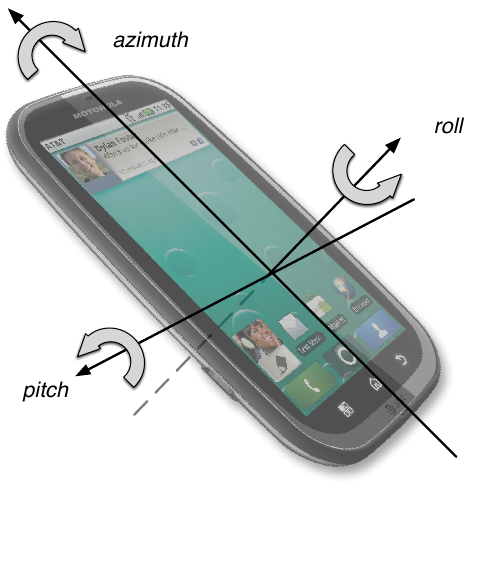
Fig. 1. Azimuth, pitch and roll axis.